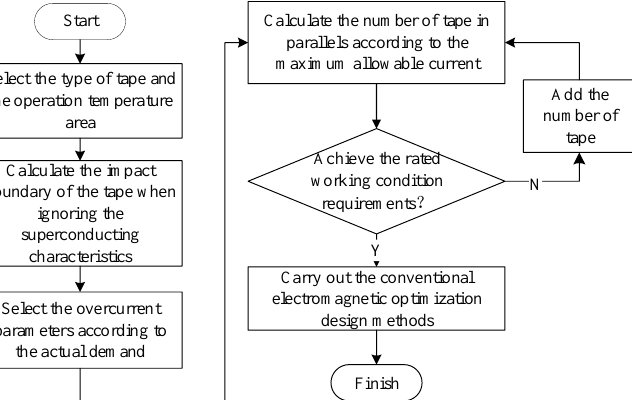
Figure 14. The electromagnetic optimization design method of the quenched limiter.